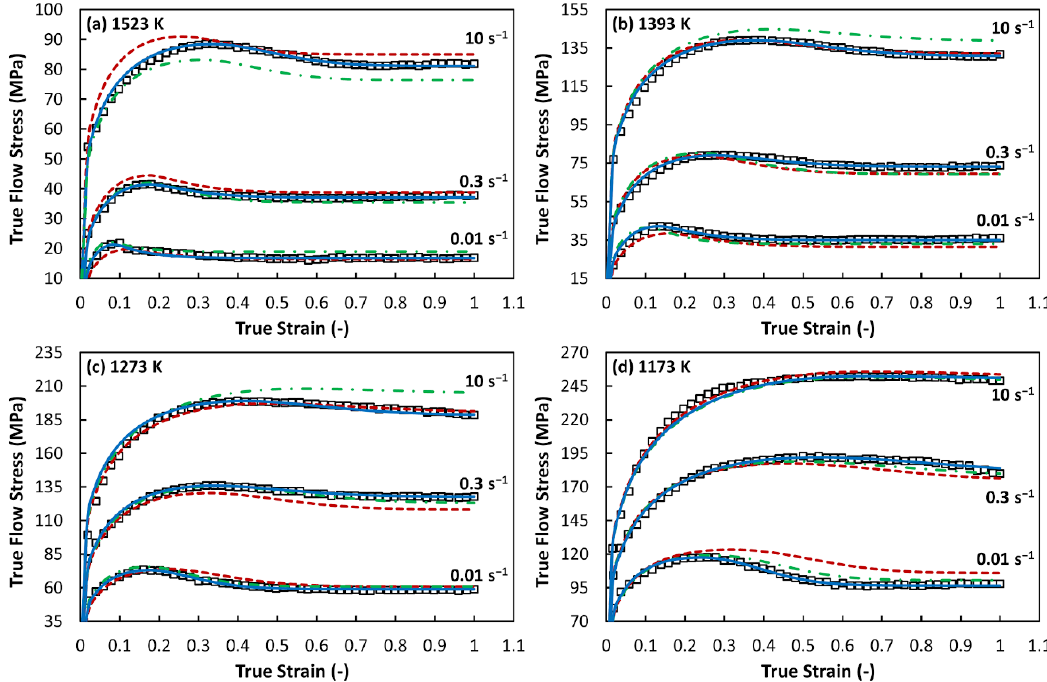
Figure 8. Comparison between the experimental and via Equation (1) approximated flow curves. ( a ) A temperature of 1523 K; ( b ) a temperature of 1393 K; ( c ) a temperature of 1273 K; and ( d ) a temperature of 1173 K. Black boxes—experimental flow curves; red dash lines—approximated flow curves (peak and steady-state calculated via the Zener–Hollomon approach); blue solid lines—approximated flow curves (peak and steady-state calculated via the multivariate polynomial approach); and green dash-dot lines—approximated flow curves (peak and steady-state calculated via the multi-layer perceptron approach).